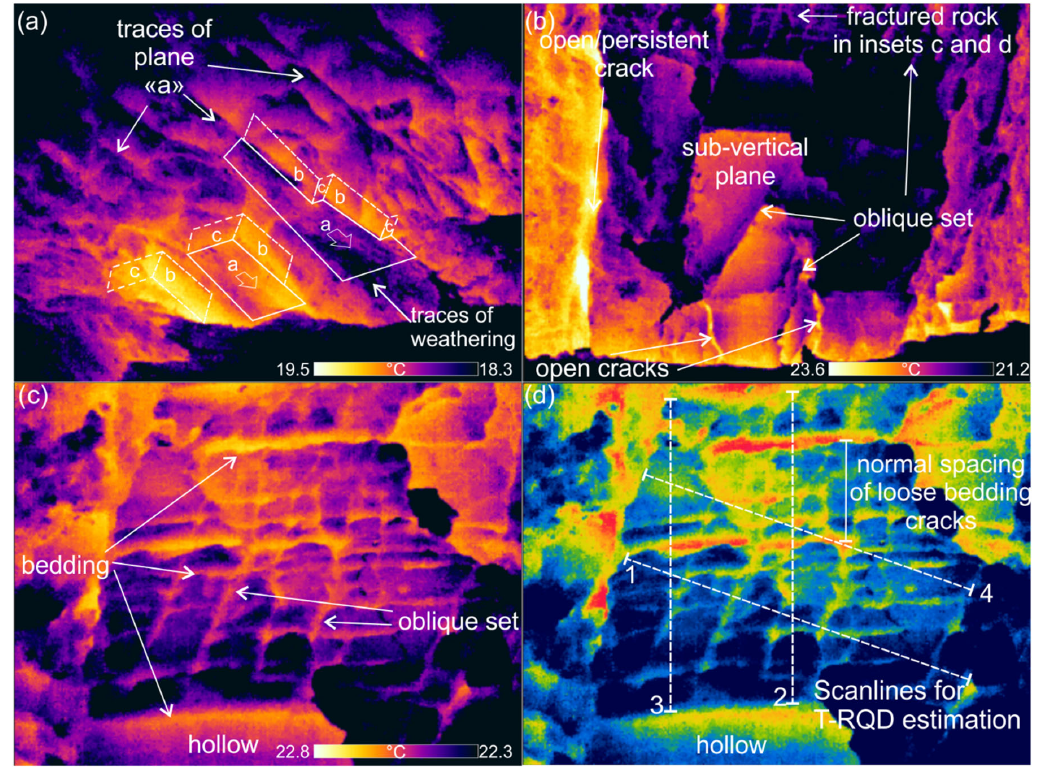
Figure 7. Post ‐ processed thermal images of RM1 ( a ), RM2 ( b ), and RM2 ′ s intensely jointed upper portion ( c ) (for location, refer to Figure 6c). Example of T-RQD estimation along scanlines on a thermal image ( d ) (for location, refer to Figure 6c). For RGB images of the rock masses, refer to Figure 2. In the post ‐ processed thermogram belonging to RM2 (Figure 7b), filtered so as to emphasize the positive anomalies (surface temperature range 21.2–23.6 °C), the highest